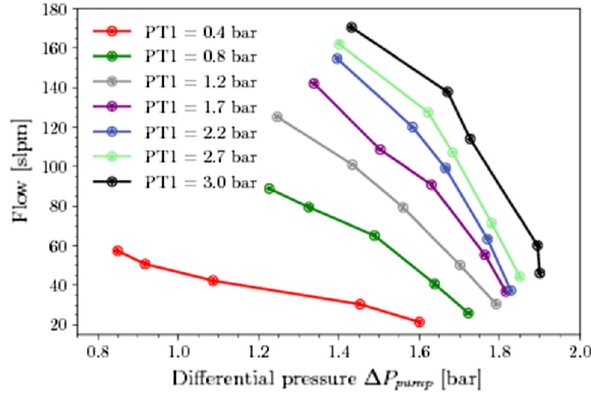
Fig. 17 Performance of the pump with xenon for different inlet pres-